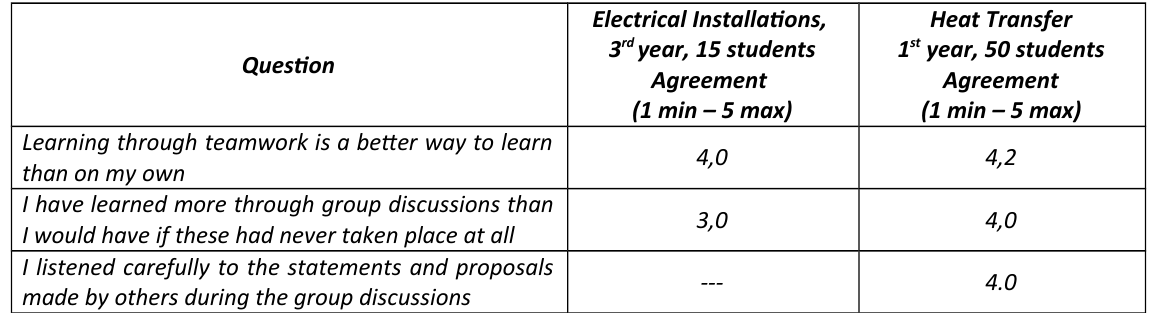
Table 2. Student’s perception about teamwork